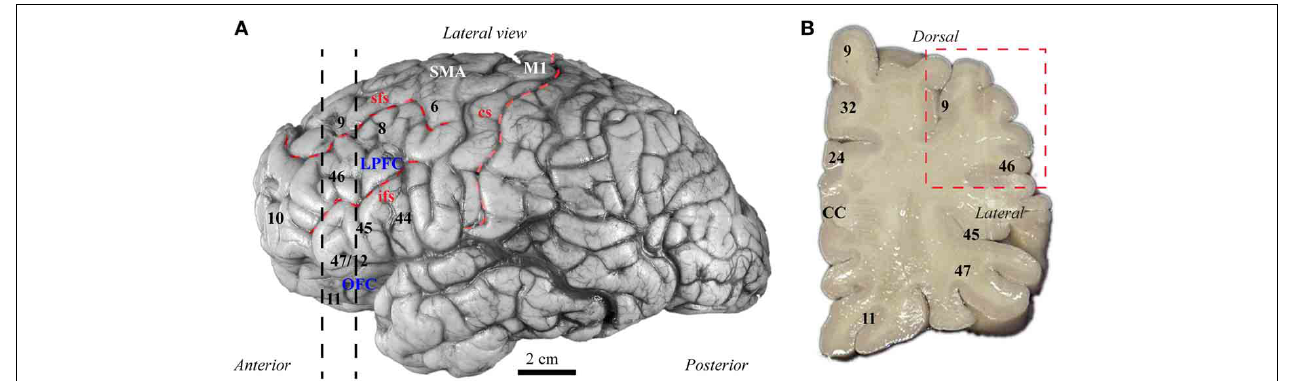
FIGURE 3 | Map of human frontal areas. (A) Lateral view of the human brain shows the dorsolateral prefrontal area 9 and its relationship with other frontal areas. Dotted lines indicate the coronal level used for analysis. (B) One